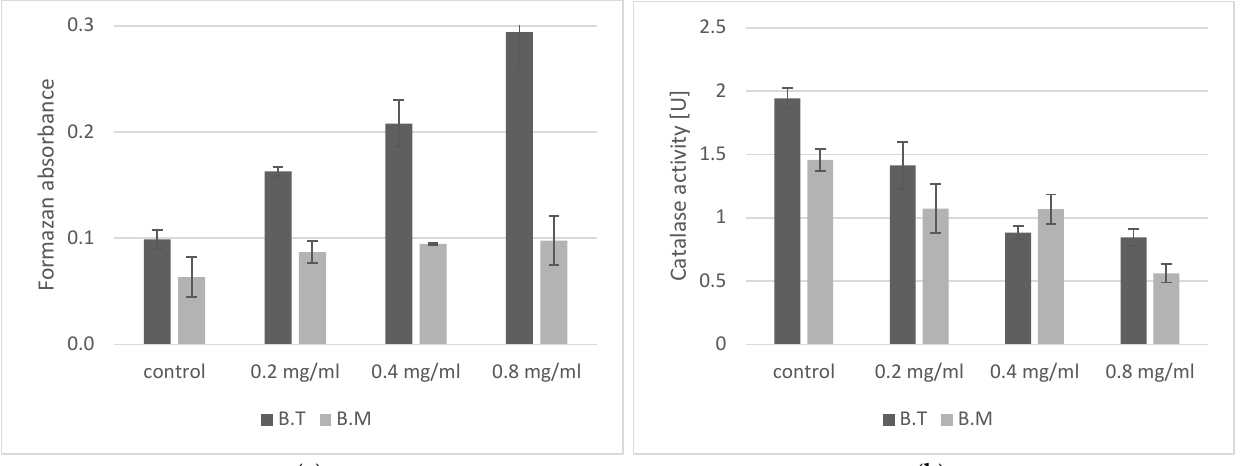
Figure 2. Parameters of oxidative stress induced by the presence of ZnO NPs in bacterial cells. ( a ) Changes to superoxide anions production in Bacillus sp. treated with ZnO NPs. ANOVA confirmed that the concentration of ZnO NPs influences the amount of formazan produced from NBT, and that the type of strain influences the amount of formazan produced in the presence of ZnO NPs. ( b ) Effect of different concentrations of ZnO NPs on catalase activity. The concentration of ZnO NPs does not statistically significantly affect catalase activity, and the type of strain does not statistically significantly affect catalase activity in the presence of ZnO NPs. B.T. — Bacillus thuringiensis, B.M. — Bacillus megaterium .